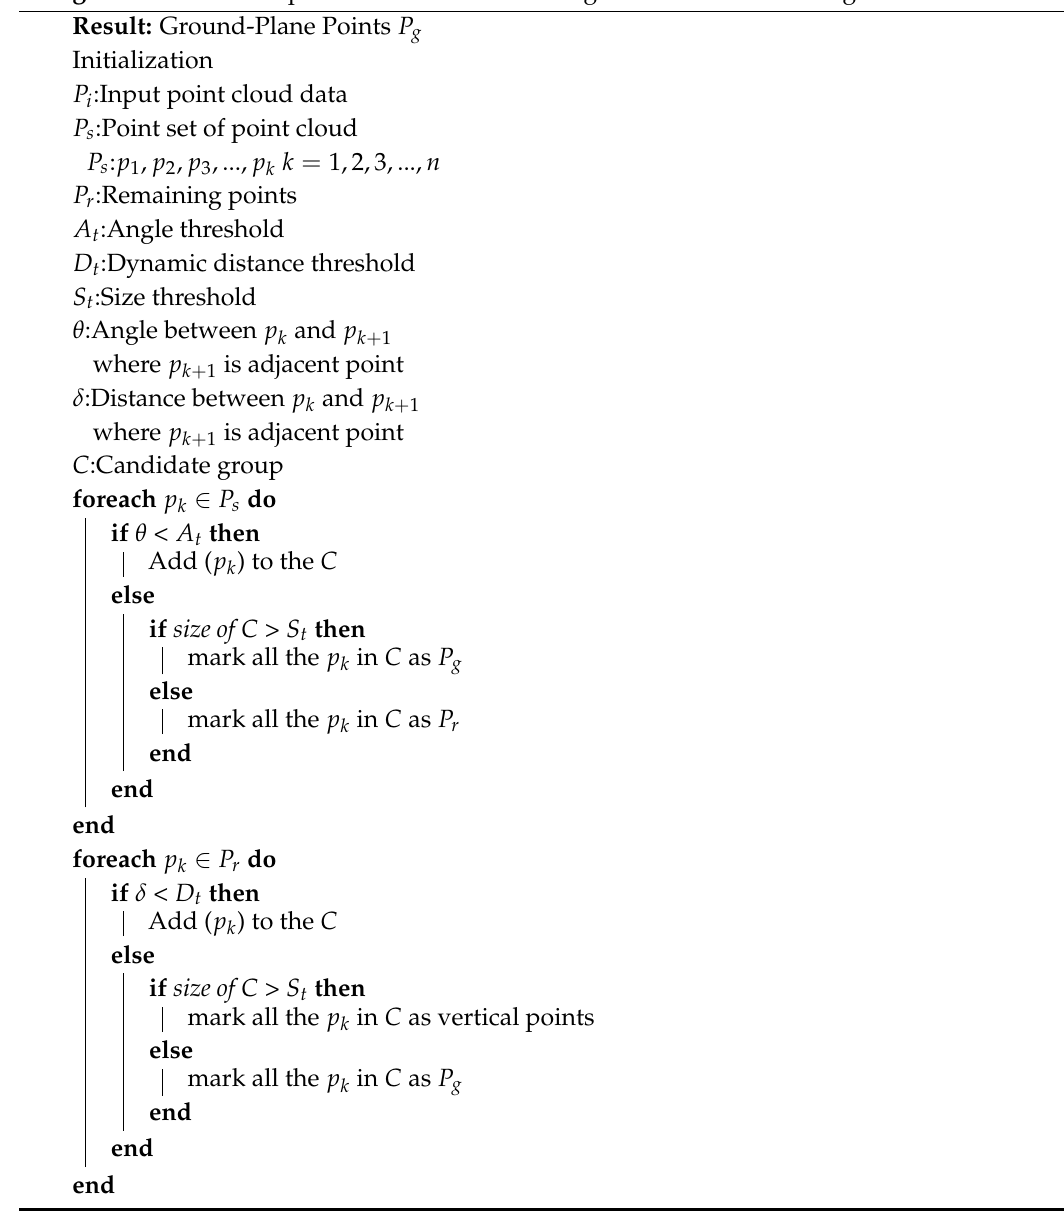
Algorithm 1: Ground plane removal based on angle and distance filtering Result: Ground-Plane Points P